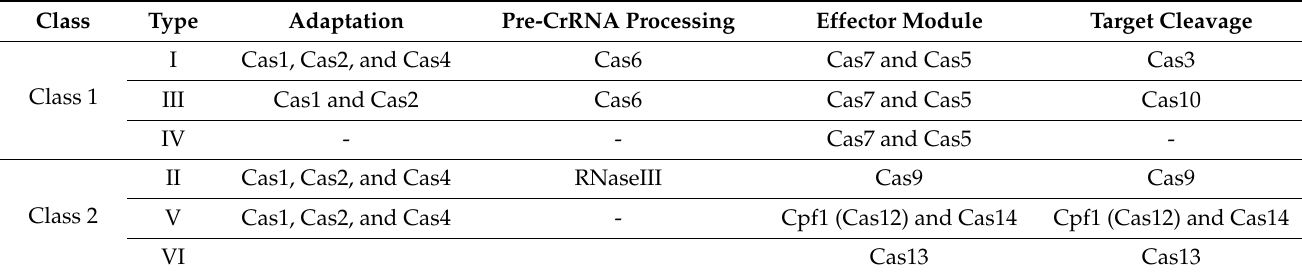
Table 1. Classification of CRISPR/Cas